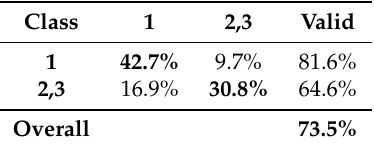
Table 7. Results from the test part of the dataset from the CNN for vehicle binary classification. Final results for each class on the main diagonal in confusion matrix (highlighted as bold) are shown.